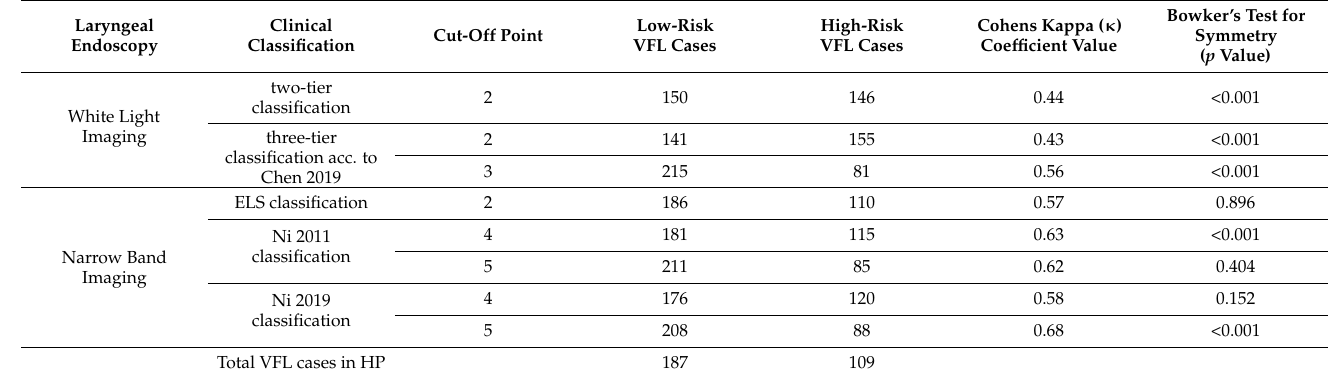
Table 3. Summary of interrater agreement between endoscopic results using White Light Imaging (WLI) or Narrow Band Imaging (NBI) and histopathological examination results using the proposed cut-off points/values according to the clinical classification used in the